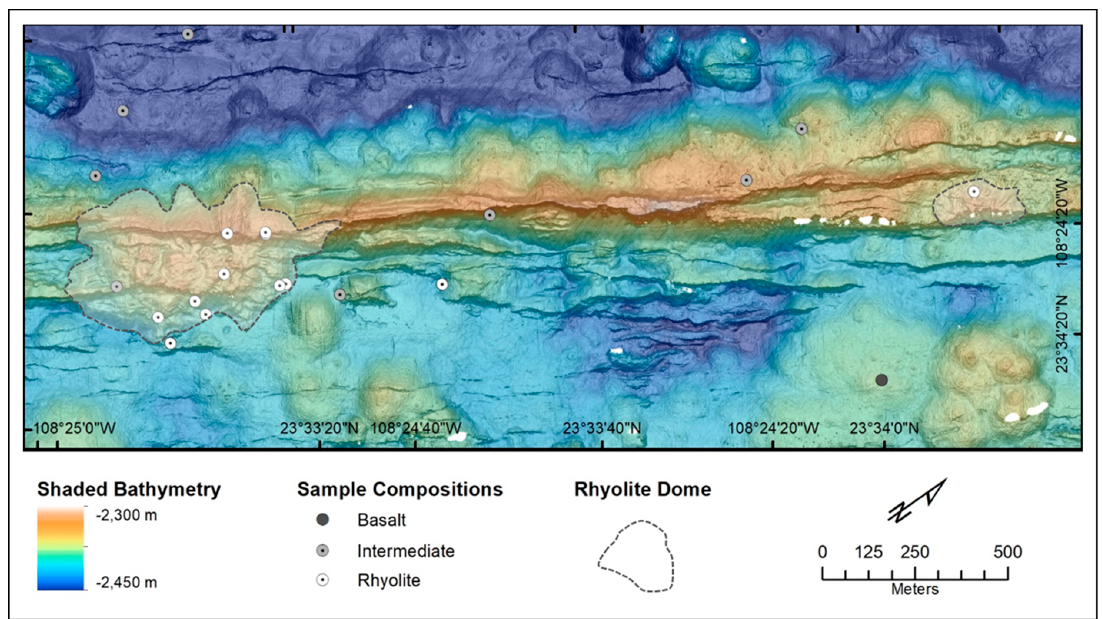
Figure 10. Map of testing data of 13 points reserved to test the classification accuracy for a rhyolitic geomorphic fingerprint, most on the main rhyolite dome, and one sample located at a smaller rhyolite dome to the north. Not all basaltic testing data are shown here.